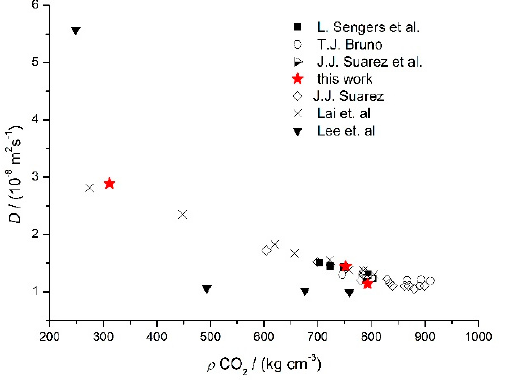
Figure 4. Diffusion coefficient for toluene in scCO 2 and comparison with literature data [32–36,39].